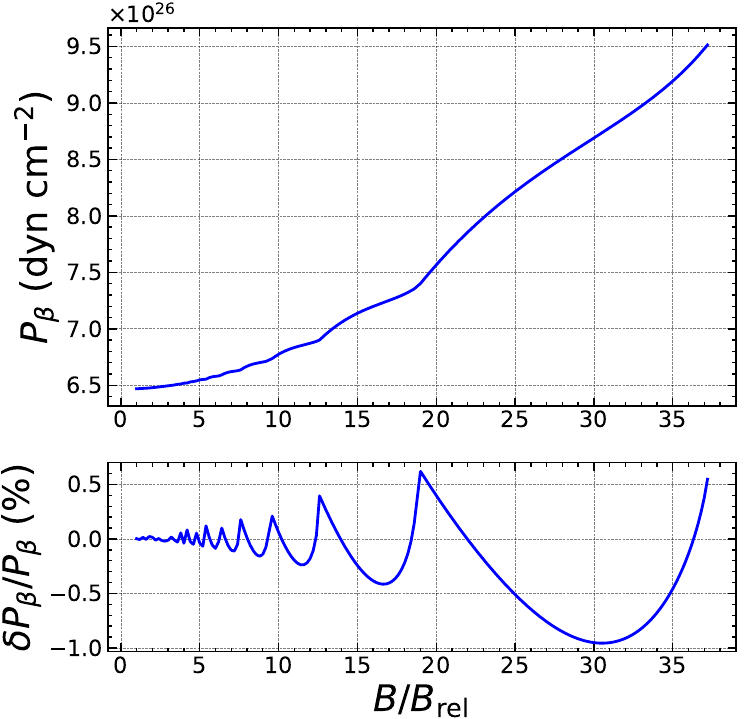
Figure 5. Top panel : Exact threshold pressure (in cgs units) for the onset of electron captures by 56 Fe as a function of the magnetic field strength B (cid:63) = B / B rel up to the onset of the strongly quantizing regime. Bottom panel : Relative error (in %) of the approximate analytical